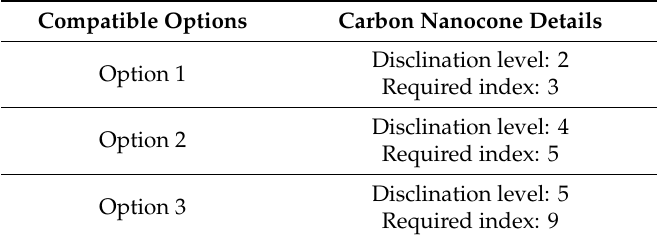
Table 1. List of compatible carbon nanocones with (4,4) or (8,0) carbon nanotubes.